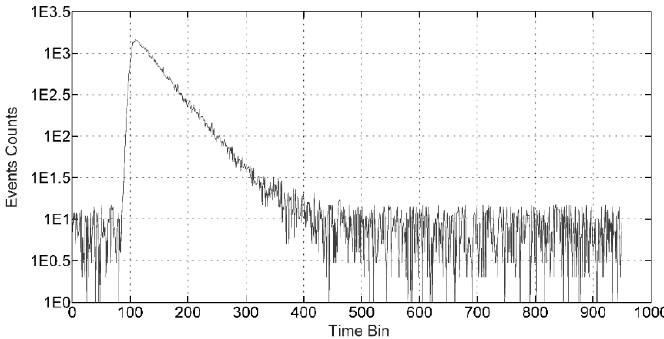
Figure 10. The events distribution under condition that background and DCR are considered.